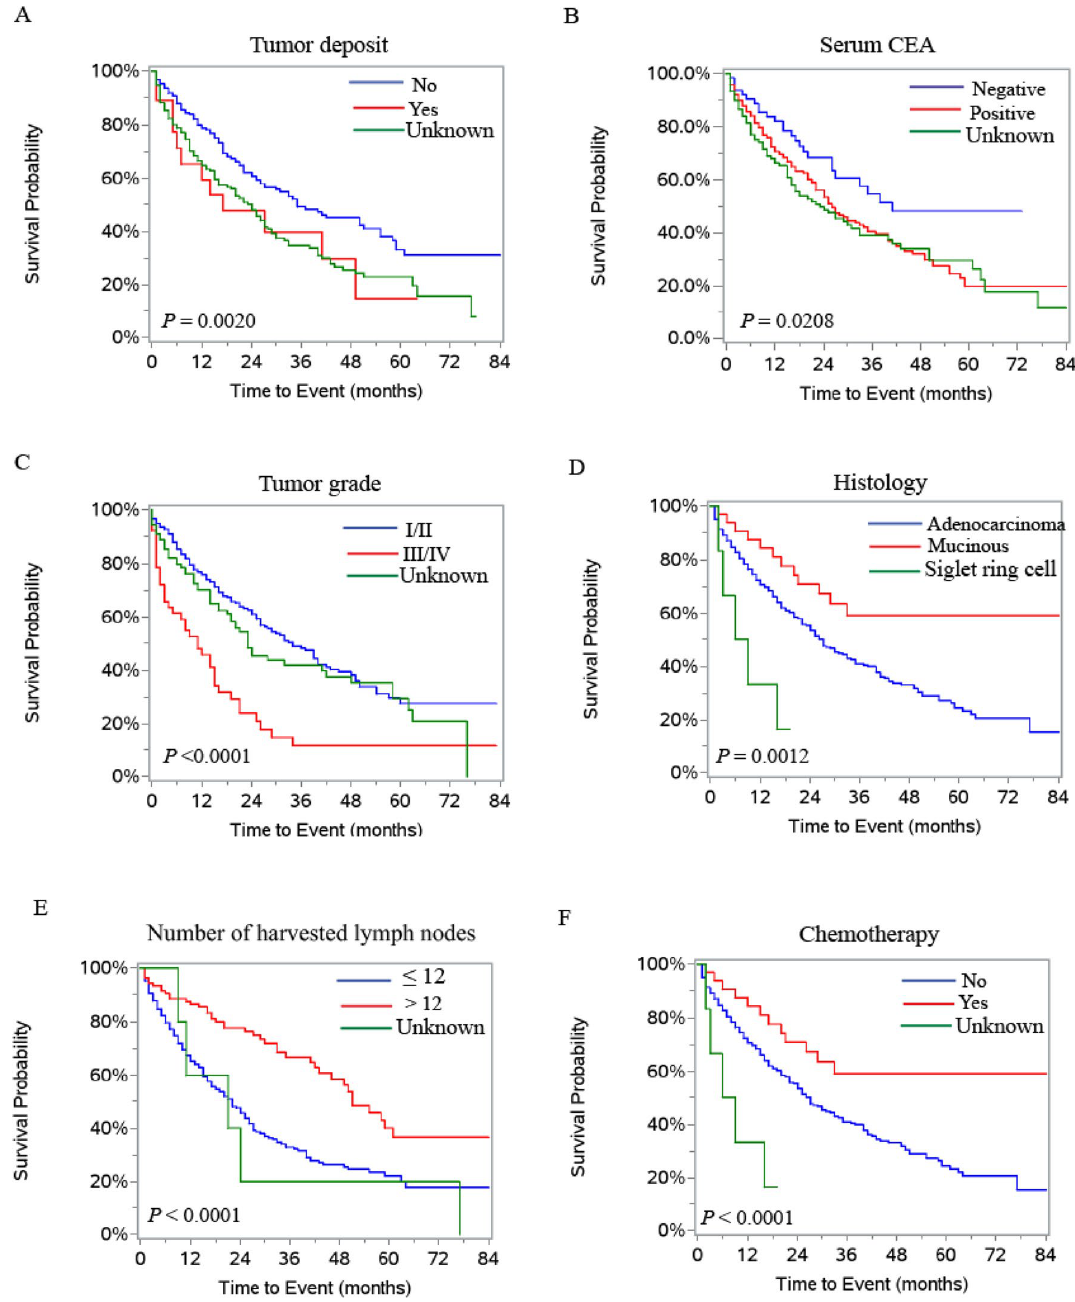
Figure 2. Kaplan–Meier survival curves for patients with stage T1 colorectal cancer. ( A ) Tumor deposits. ( B ) Serum CEA. ( C ) Tumor grade. ( D ) Histology. ( E ) Number of harvested lymph nodes. ( F )